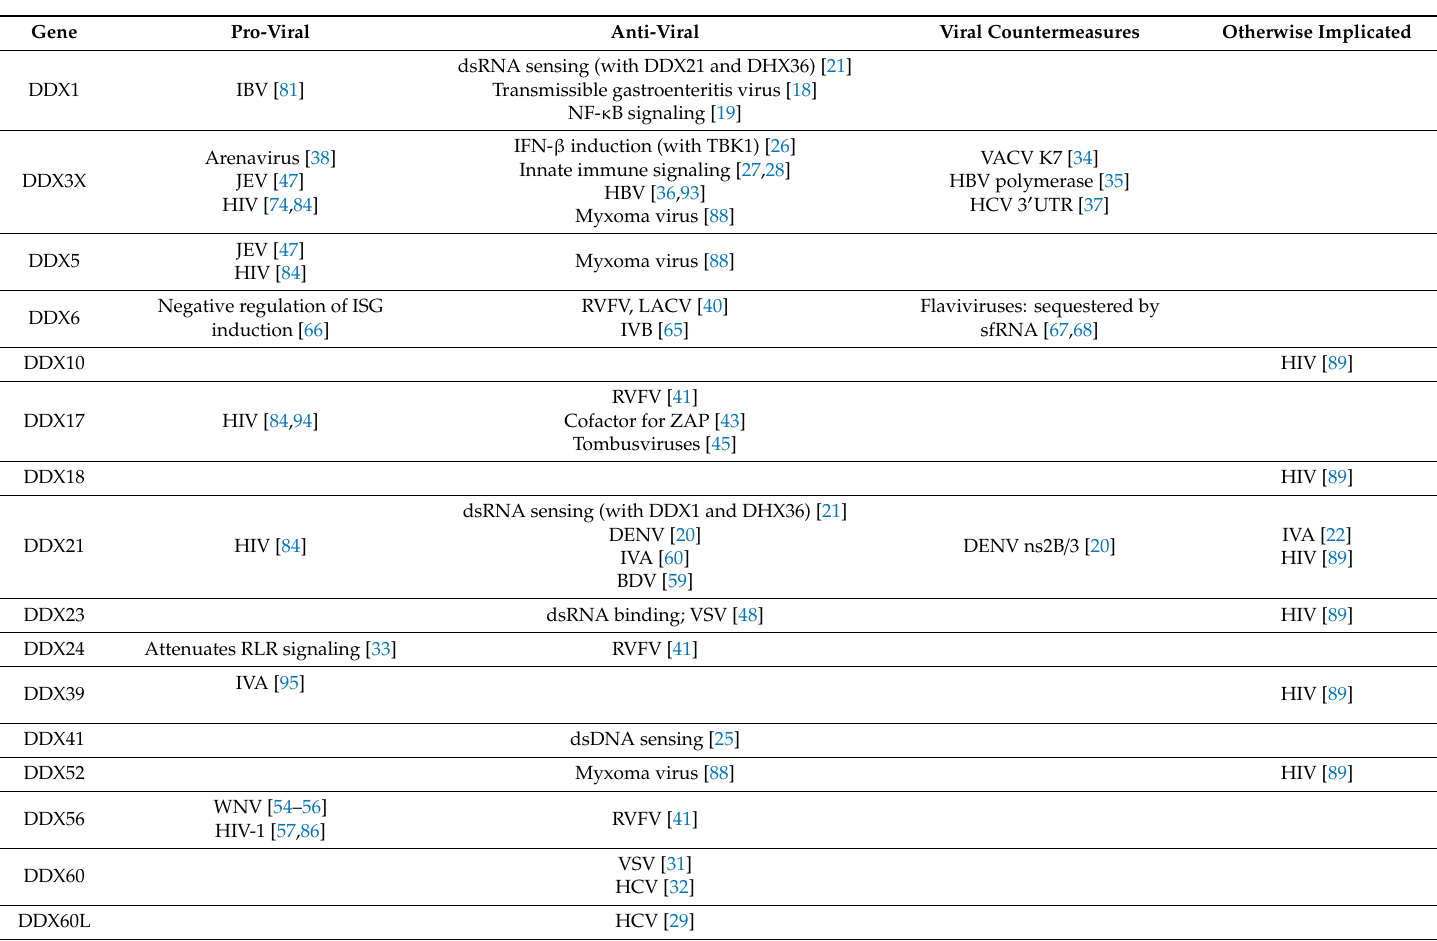
Table 1. DEAD-box helicase relationships with viral infections. Interactions are categorized as pro-viral if they support viral replication, and they are categorized as anti-viral if they counteract viral infection either directly or by activating innate immune signaling. Viral countermeasures are listed if a viral component disrupts an otherwise antiviral interaction. Other categories of interactions including gene expression changes are listed in the otherwise implicated